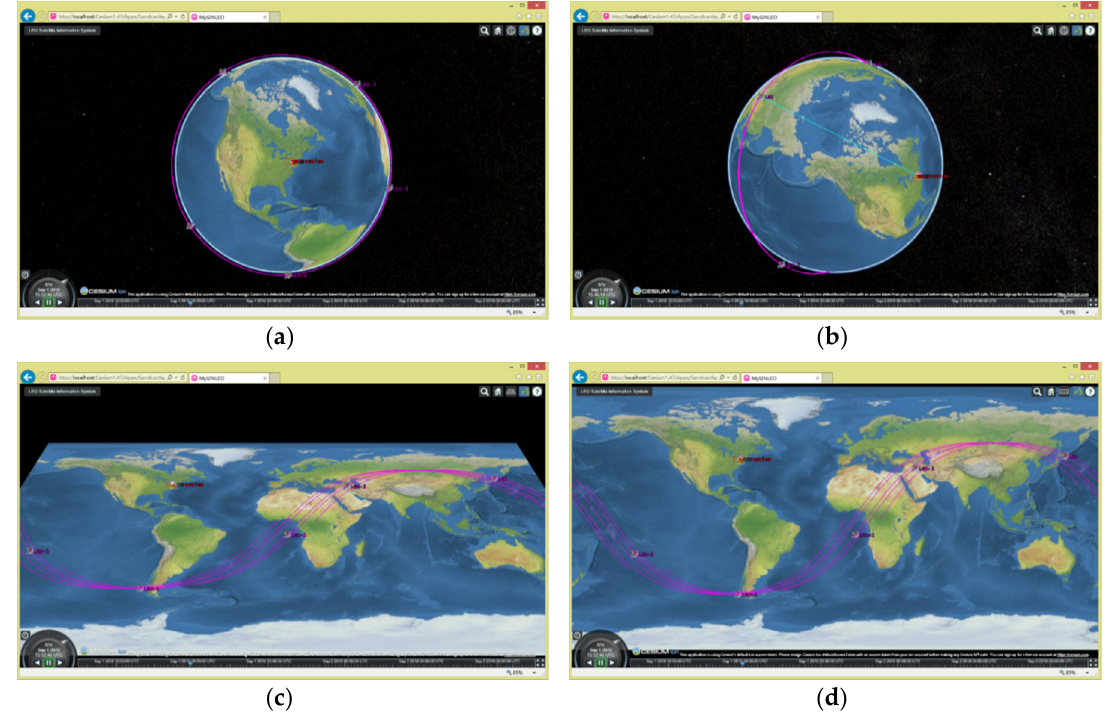
Figure 12. The view display of the LEO satellite information system: ( a ) The specific network form of the LEO satellite system from the ground station point; ( b ) the satellite is connected with the station and the data is transmitting; ( c ) 2.5D view of the LEO satellite information system; ( d ) 2D view of the LEO satellite information system.